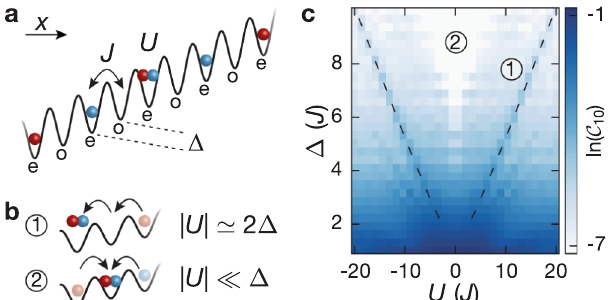
Fig. 1 Illustration of the experimental setup and the structure of the Hilbert space. a Schematic of the tilted 1D Fermi-Hubbard model (with odd o and even e sites) with tunneling J , on-site interaction U and spin- dependent tilt Δ ↑ , Δ ↓ (spin-up red, spin-down blue). b Dominant resonant tunneling processes for different regimes. c Finite-time connectivity C ϵ (for a cut-off ϵ = 10%) de fi ned as the fraction of states that participate in the dynamics up to an evolution time T N ¼ 1000 τ (main text, “ Methods ” ). The calculation was performed for a Néel-ordered singlon CDW initial state, using exact diagonalization (ED) with system size L = 13 and Δ ↑ = Δ ↓ ≡ Δ . In the large-tilt limit, Δ / J → ∞ , we fi nd emergent strongly-fragmented effective Hamiltonians for regime ① and ② (see Supplementary Note 3 and